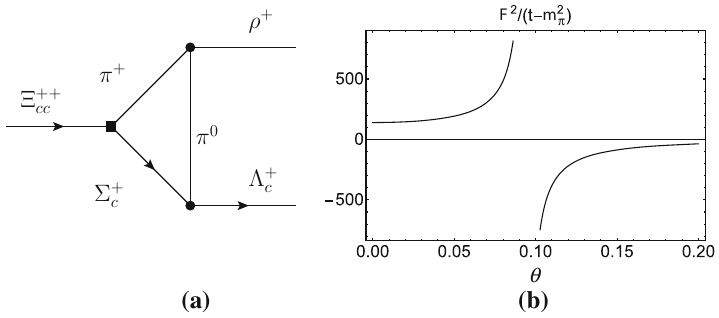
Fig. 5 a An example with possible contribution of on-shell exchanged particle. b Dependence of the Breit–Wigner like